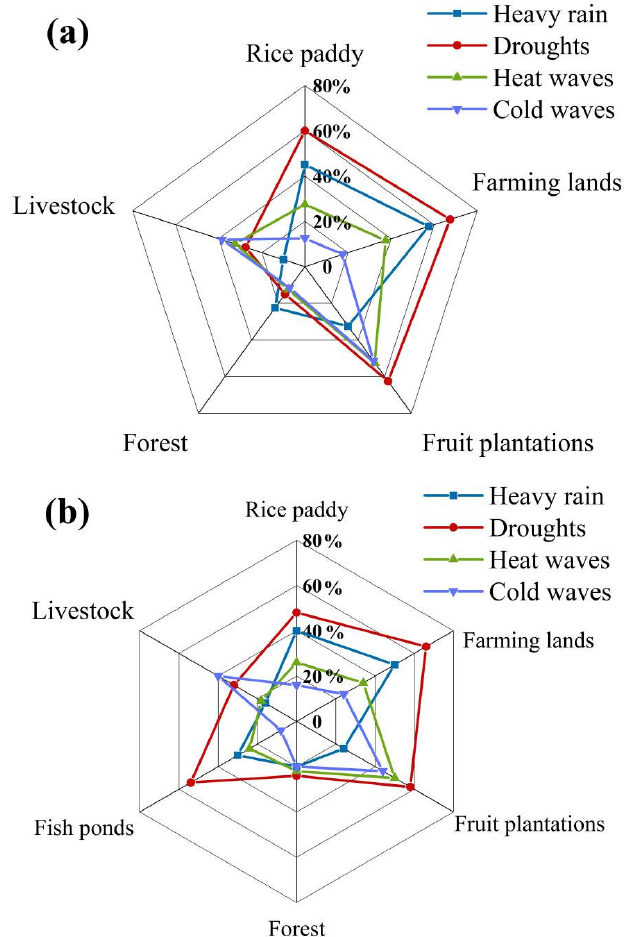
Figure 7. The perceived impacts of weather extremes on agricultural systems in Paotong ( a ) and Dantu ( b ) villages.